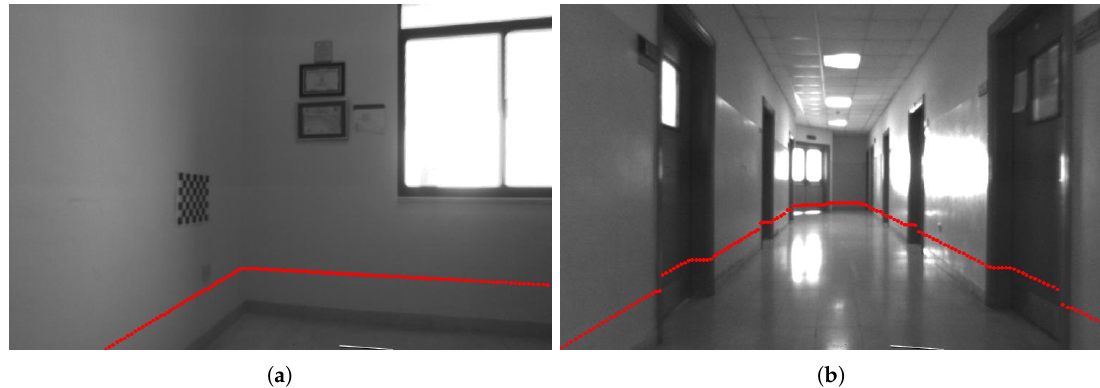
Figure 9. Configuration 1: Projection of lidar data to two test images using the estimated Z matrix (points are shown in red color): ( a ) first test image; ( b ) second test image.